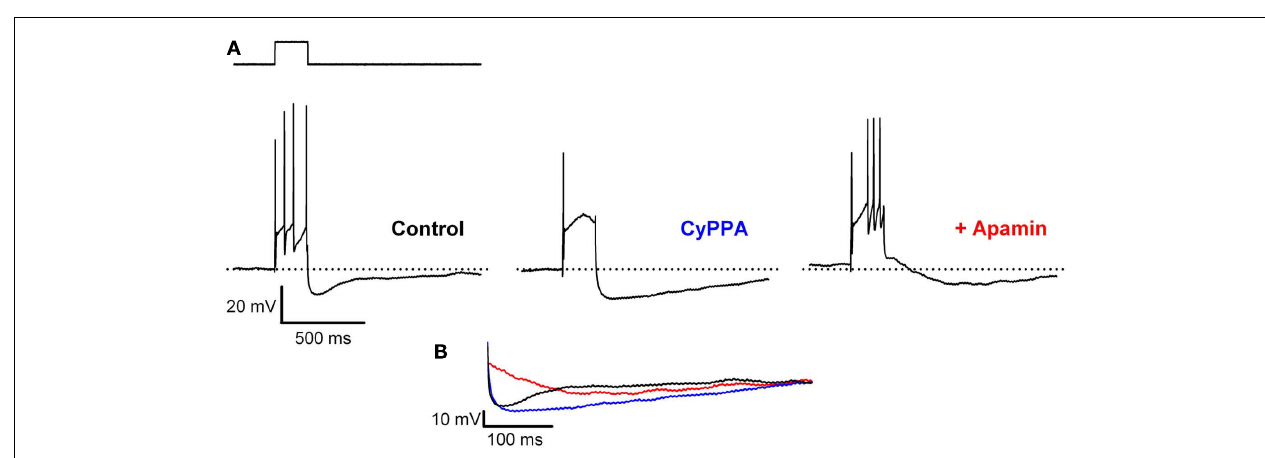
co-application of 300nM apamin (right).The dotted line indicates the V m ( − 56mV) prior to first control current injection. (B) Overlays highlighting the prolongation of the ptAHP by CyPPA, and the presence of a slow apamin insensitive component.